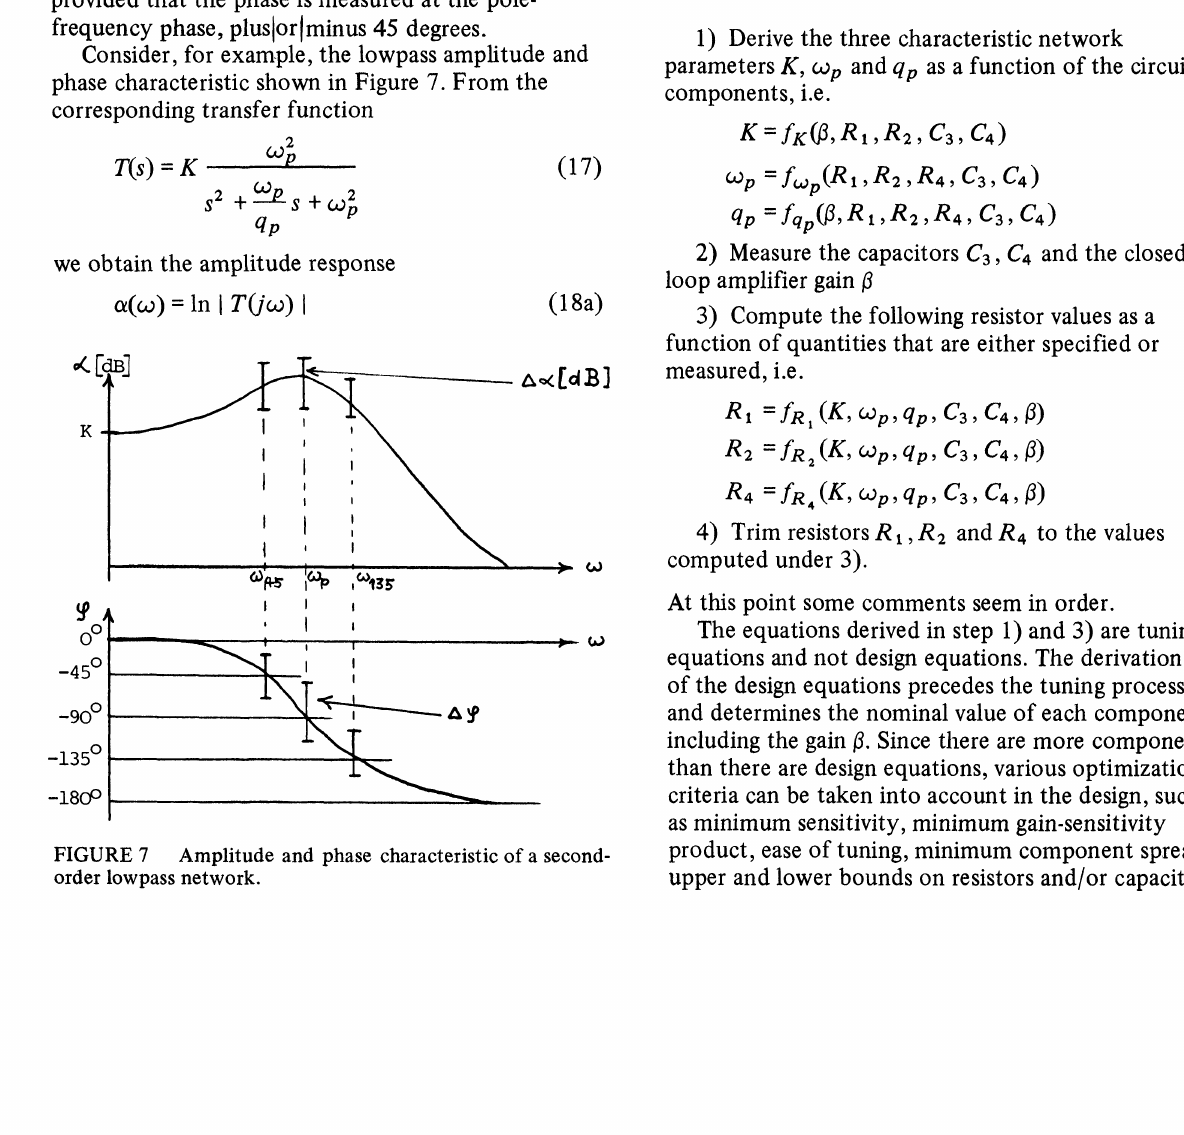
FIGURE 7 Amplitude and phase characteristic of a second- order lowpass